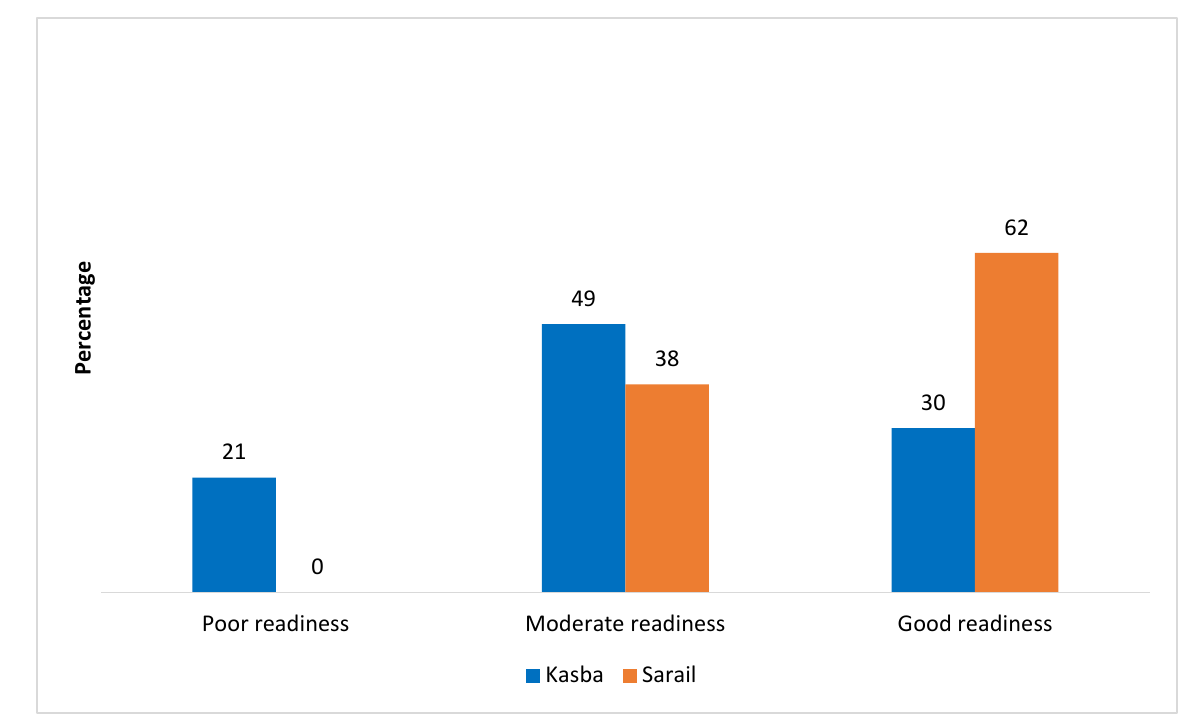
Figure 3. Readiness status of CCs at Kasba (n = 33) and Sarail (n = 21).